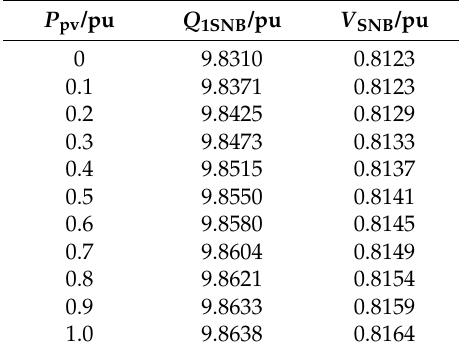
Table 1. The values of the load’s reactive power and the voltage at the saddle-node bifurcation (SNB) points of the three-node system with the photovoltaic cell (PV).